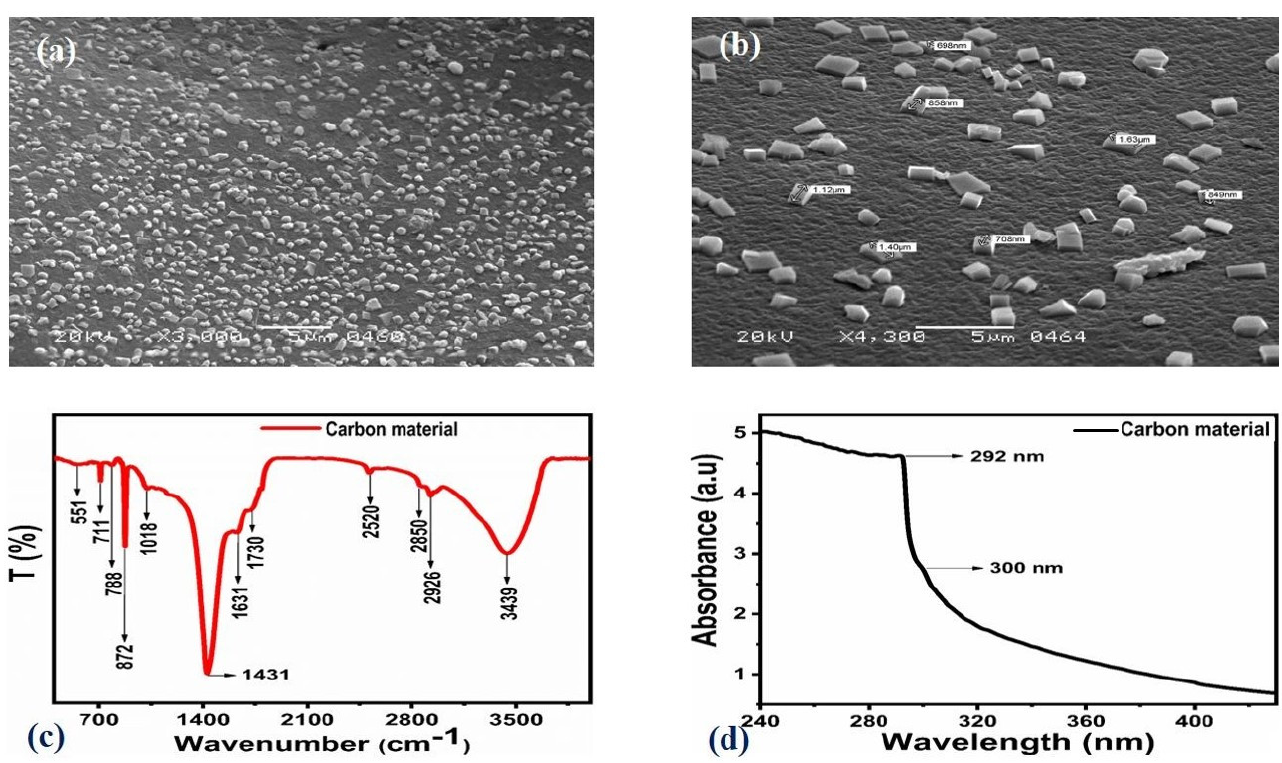
Figure 1. ( a , b ) Different magnified SEM images of carbon material from phalsa. ( c ) Functional group analysis of carbon material by FTIR. ( d ) Optical characterization of carbon using UV-visible spectroscopy.